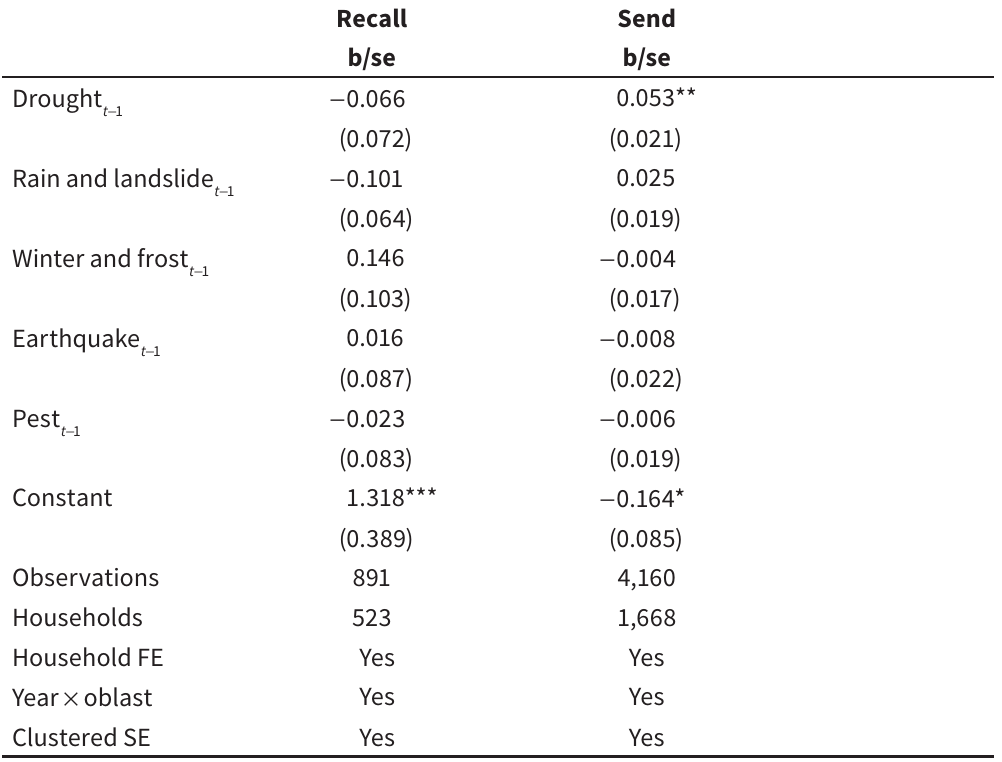
Table 8 Shocks and decision to recall and send migrants Recall Send b/se